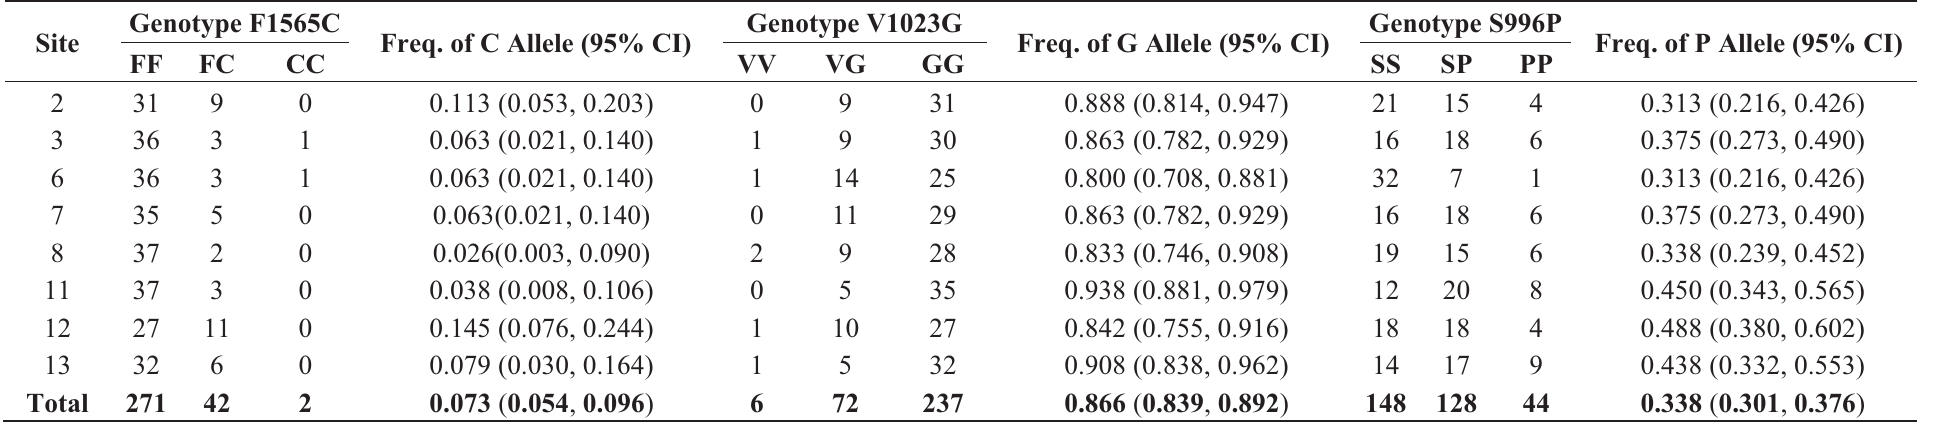
Table 3. HRM assay results for Vssc F1565C, V1023G and S996P mutations of Aedes aegypti from Yogyakarta Season